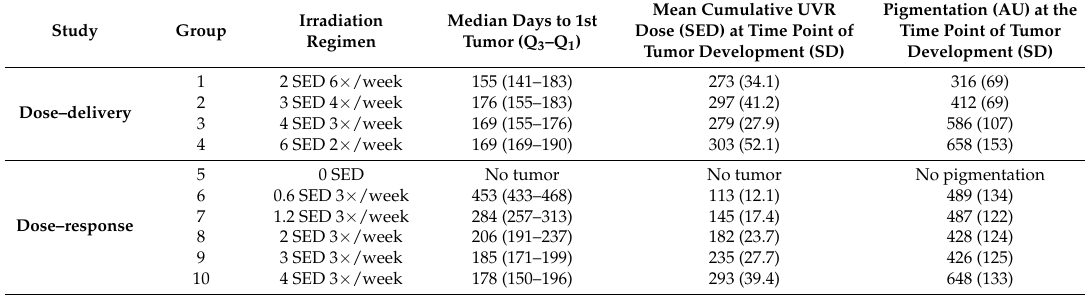
Irradiation Median Days to 1st Group Regimen Tumor (Q 3 –Q 1 )